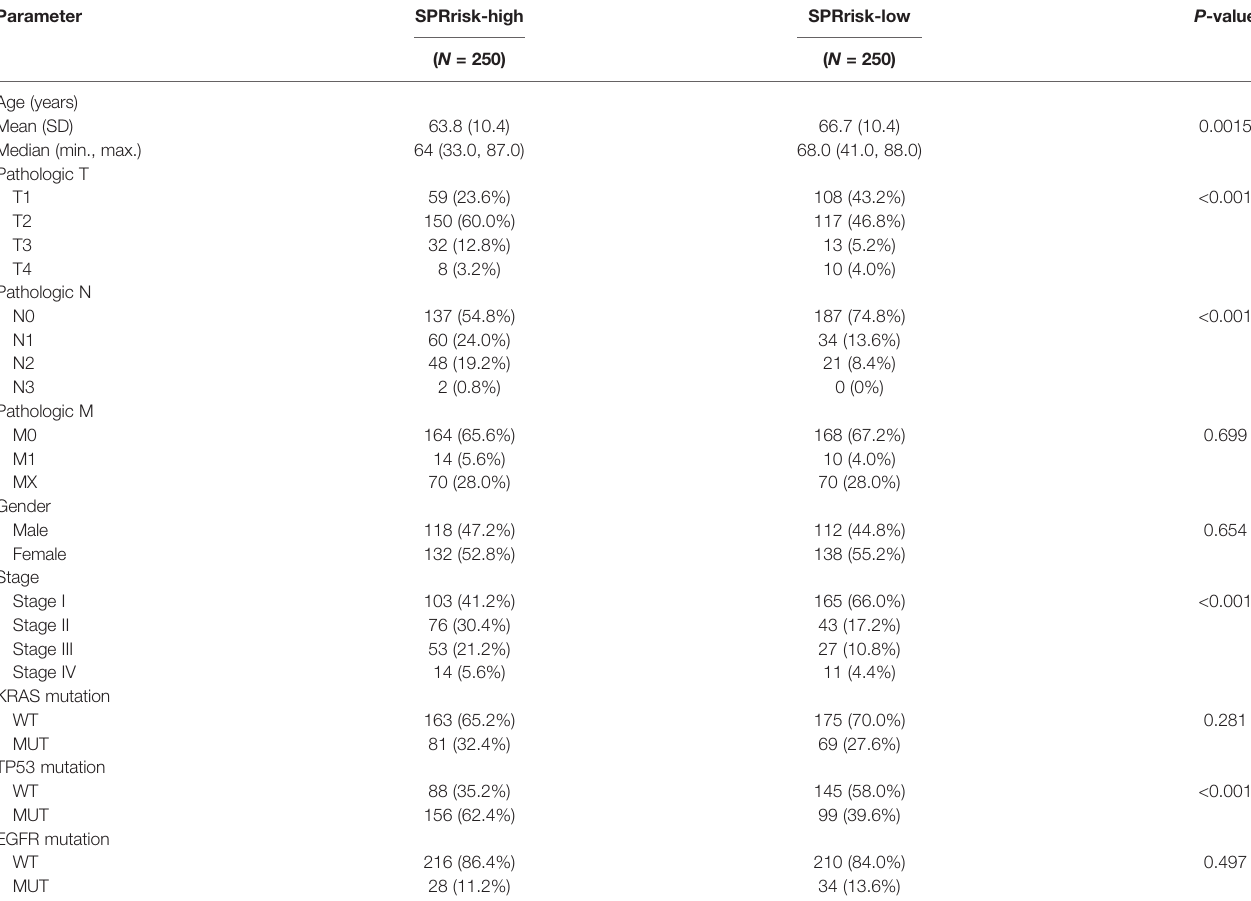
TABLE 1 | Clinical and pathological characteristics of high- and low-risk patients in The Cancer Genome Atlas lung adenocarcinoma data set.